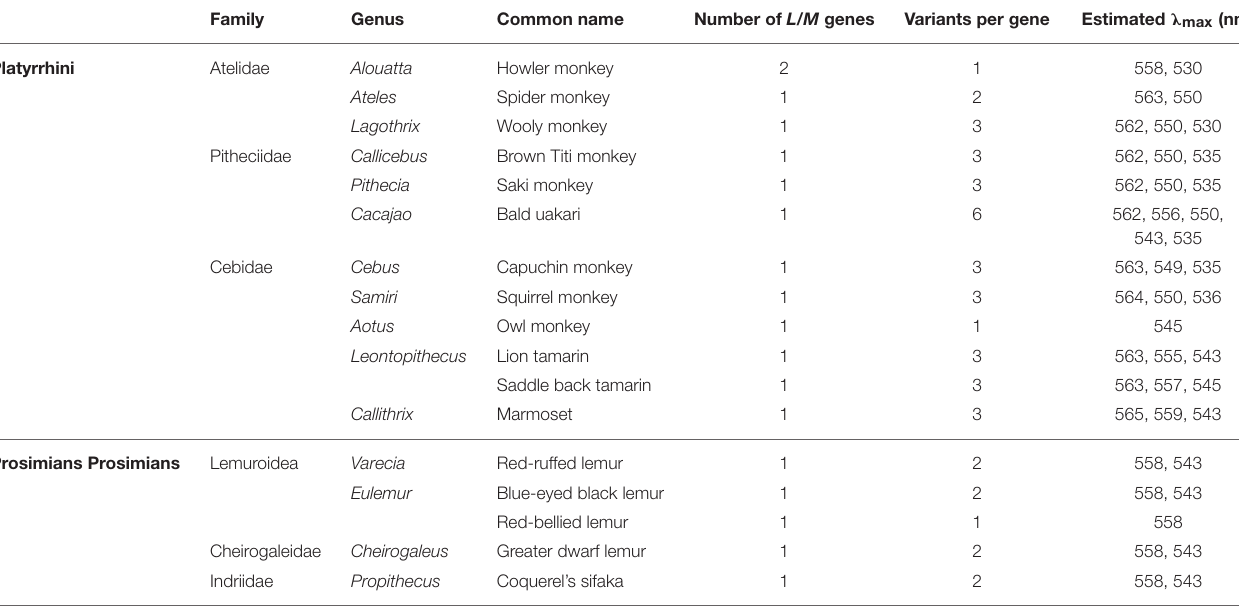
TABLE 1 | The allelic variation found in the LWS/MWS ( L/M cone opsin) genes of New World monkeys and